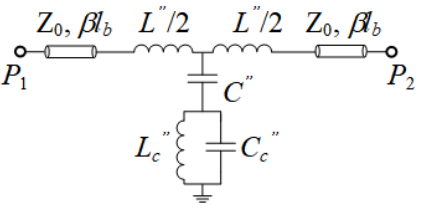
Figure 4. Layout ( a ) and lossless frequency response ( b ) of the folded and 90° rotated DB-DGS. Dimensions are identical to those of Figure 3.